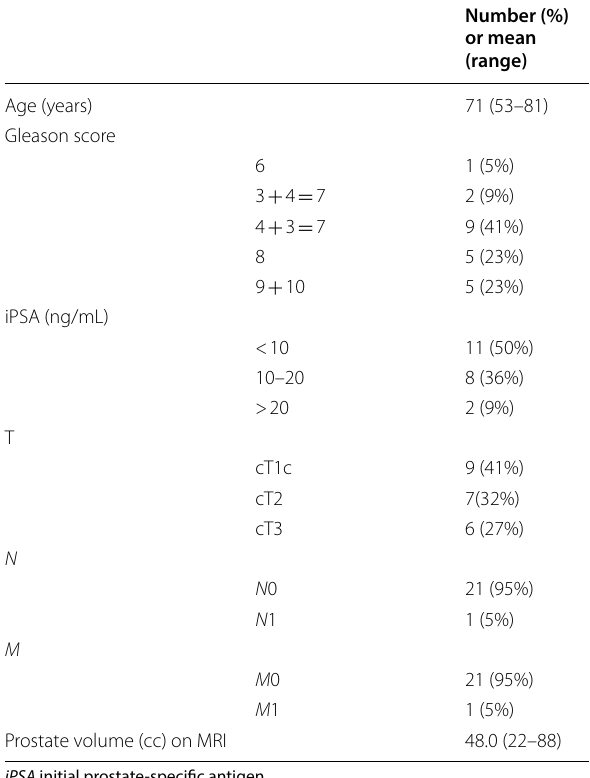
Table 1 Demographics of the patients included in this study. Data are shown as absolute value (percentage) or as mean